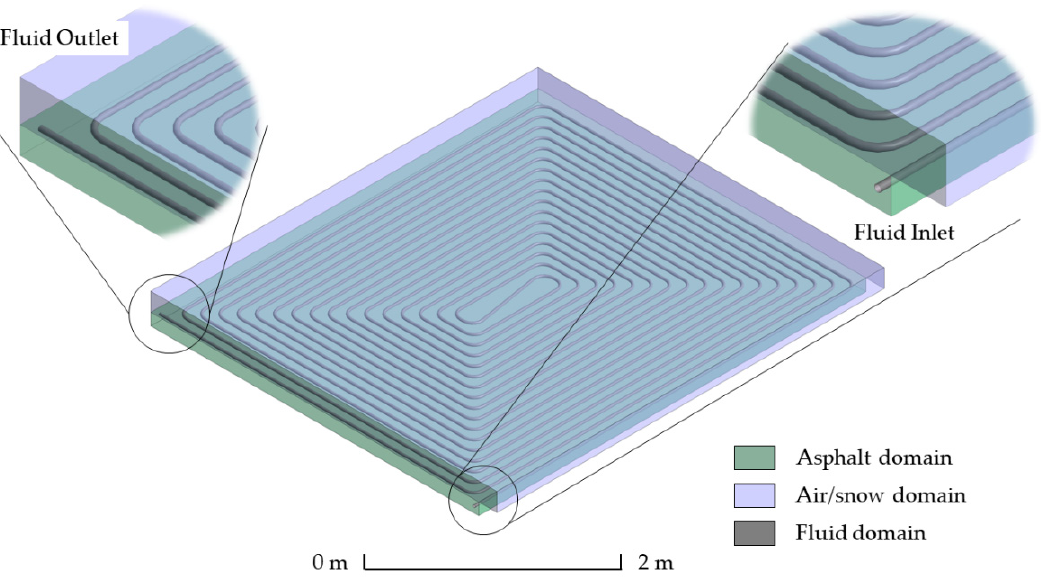
Figure 5. Three-dimensional CAD geometry developed in the CFD model for a single hydronic road-heating circuit and close-up of heating fluid outlet and inlet.